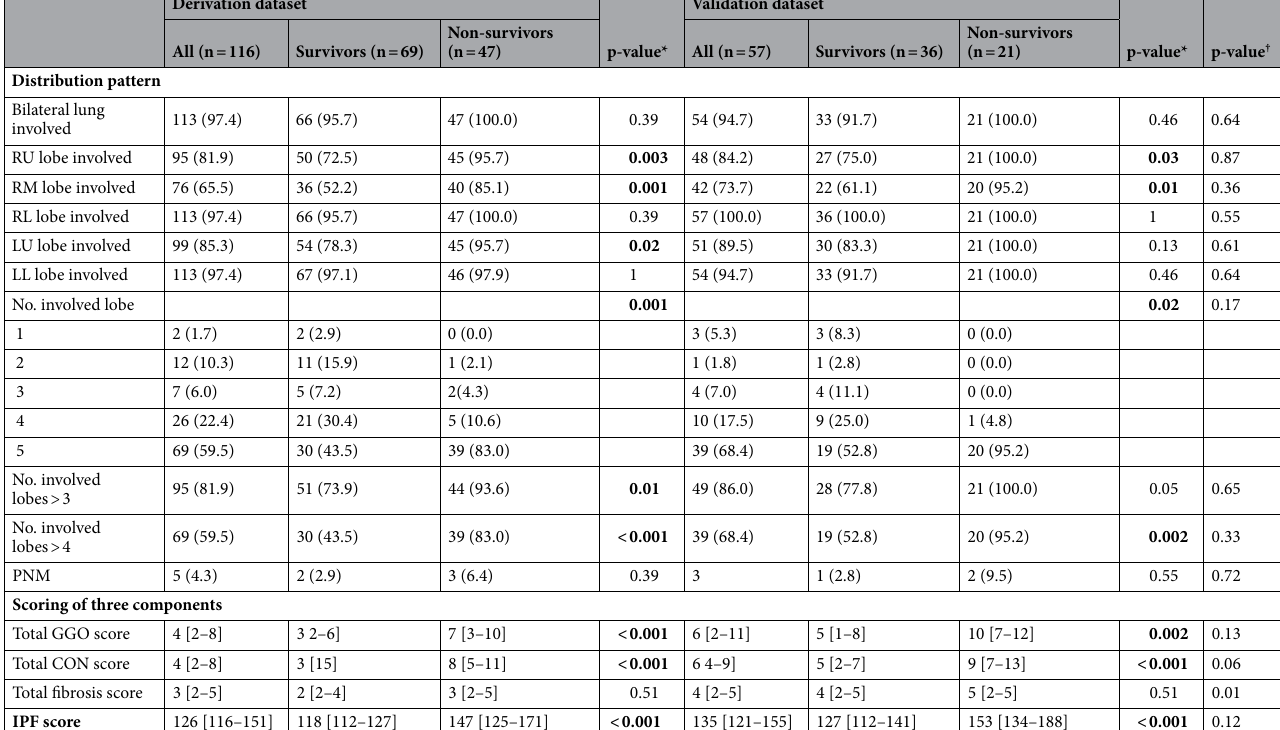
Table 1. Comparison of visual CT features between two datasets with different outcome. Data are presented as median [IQR] for continuous variables and number (frequency) (%) for categorical variables. * A comparison between the survivors and non-survivors groups. † A comparison between the derivation and validation datasets. CT, computed tomography; RU, right upper; RM, right middle; RL, right lower; LU, left upper; LL, left lower; PNM, pneumomediastinum or pneumothorax; GGO, ground-glass opacity; CON, consolidation; IPF score, idiopathic pulmonary fibrosis based visual scoring method.